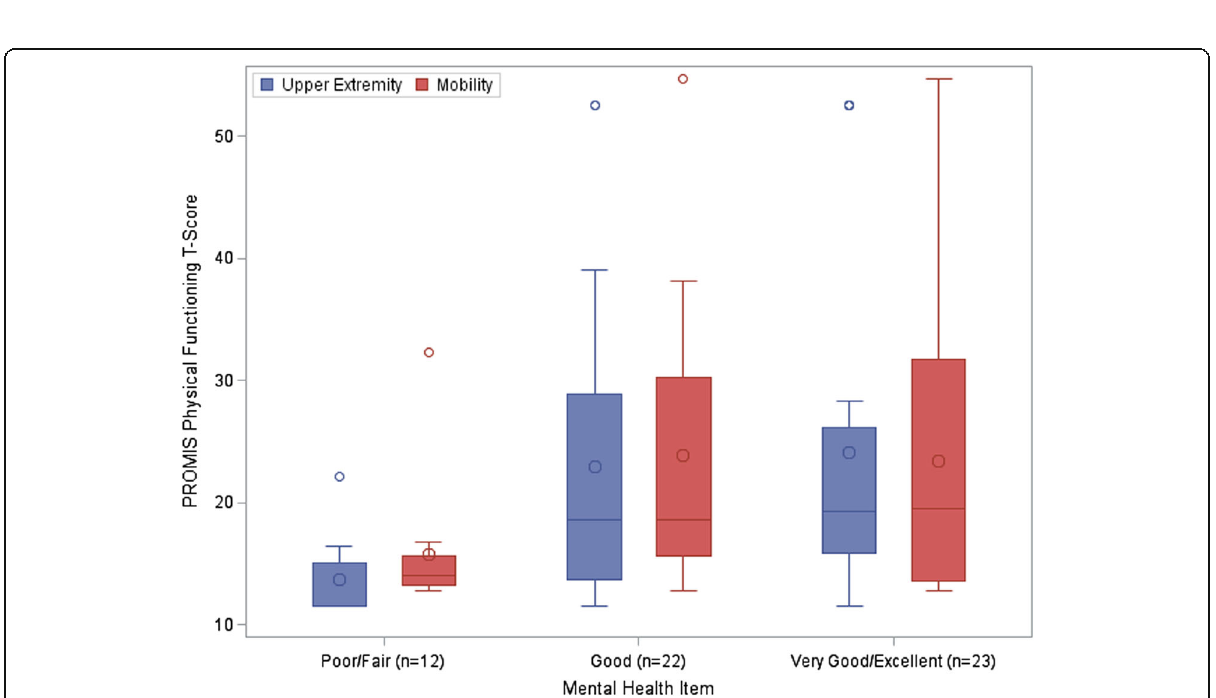
Fig. 2 Boxplots of PROMIS physical function T-scores by mental health item score. Spearman correlation for Upper Extremity: r = 0.35 ( p = 0.008); Spearman correlation for Mobility: r = 0.21 ( p = 0.12). Note: the line within the box represents the median; the circle within the box represents the mean; the length of the box represents the interquartile range; the length of the whiskers represents the distance between the box and the observation that is less than 1.5 times the interquartile range; the points outside the whiskers represent